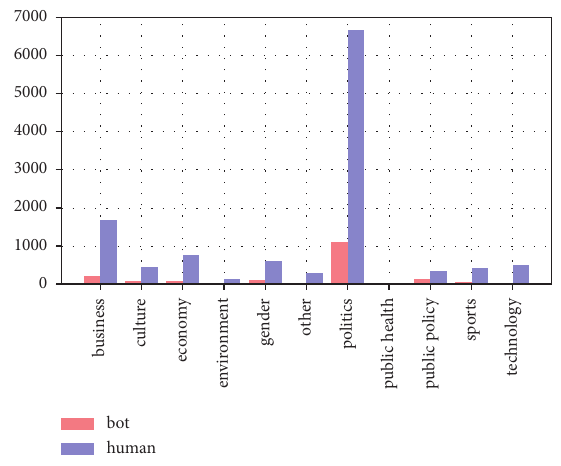
Figure 5: Distribution of bots in secondary communication for 121 The New York Times reports’